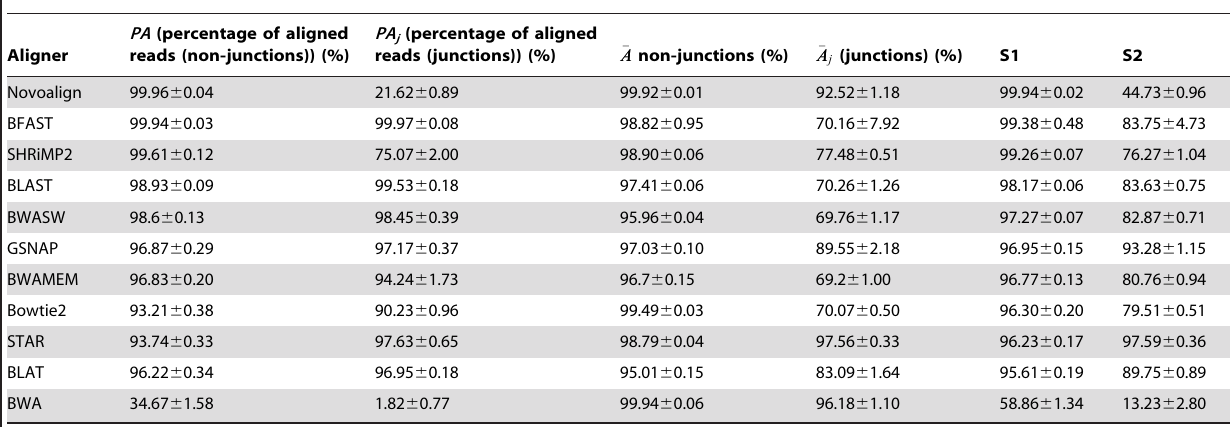
Shows the summary of alignment results aggregated over four viral genomes for non-mutated viral reference sequences and sorted by S1 score. The average alignment accuracy for reads crossing splice junctions ( (cid:2) AA j ) and those not crossing splice junctions ( (cid:2) AA ) is defined in the Materials and Methods section.